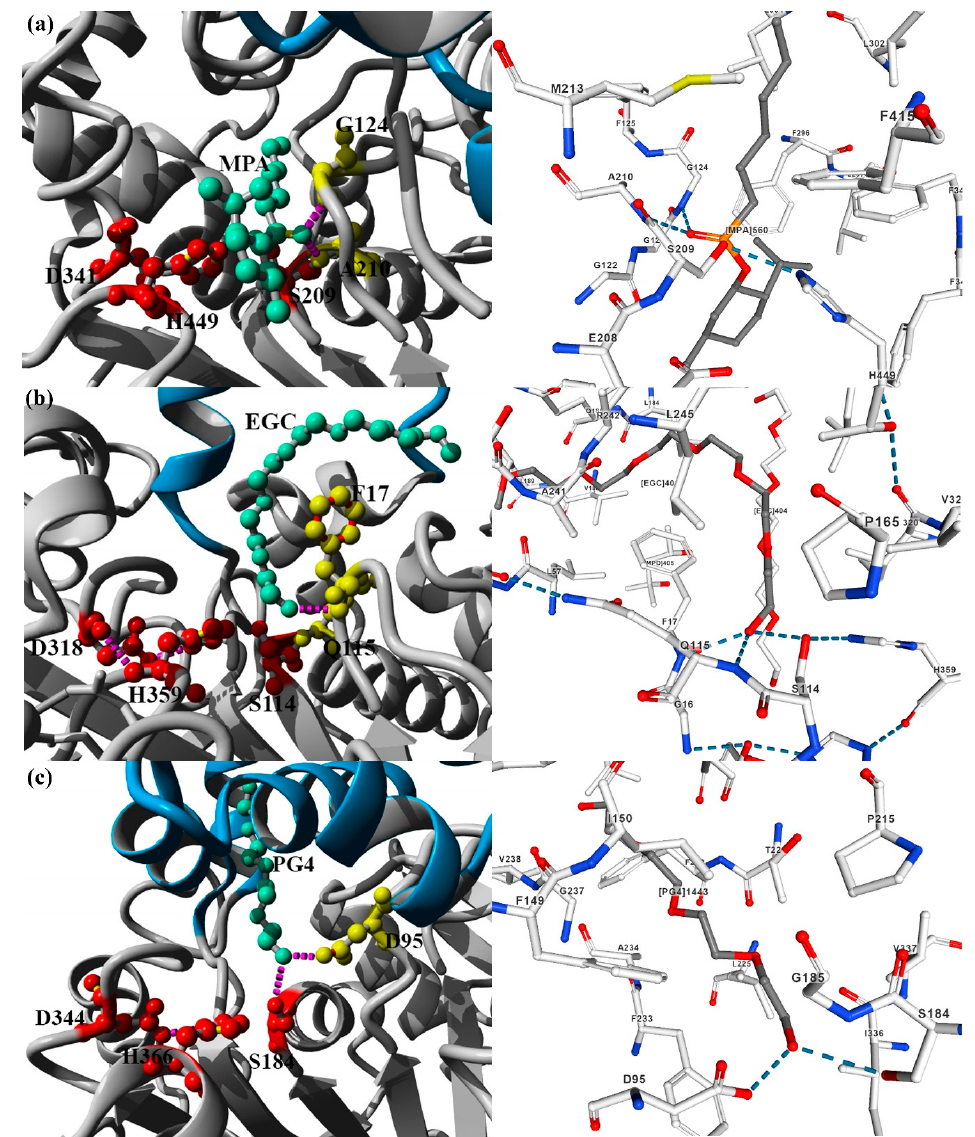
Figure 2. Three types of oxyanion holes. ( a ) GGG X type in Candida rugosa PDB (1LPM): (1R)- Menthyl hexyl phosphonate (MPA), inside binding area stabilized by hydrogen bonds of two oxyanion hole residues Ala 210 and Gly 124 [66]. ( b ) GX type in Geobacillus thermocatenulatus lipase (PDB 2w22): Triton X-100 (EGC), stabilized by hydrogen bonds of two oxyanion hole residues Phe 17 and Gln 115 [67]. ( c ) Y type in Candida antarctica lipase PDB (2VEO): (PG4) Polyethylene glycol stabilized by hydrogen bonds of one oxyanion hole residue Asp 95 [59]. Magenta dotted lines represent hydrogen bonds, green color molecules represent the substrates, red color residues are the active sites residues and yellow residues represent the oxyanion hole residues. (Figures prepared by http: // www.yasara.org) [68]. The cartoon representation was rendered with an NGL viewer (generated from www.rcsb.org)